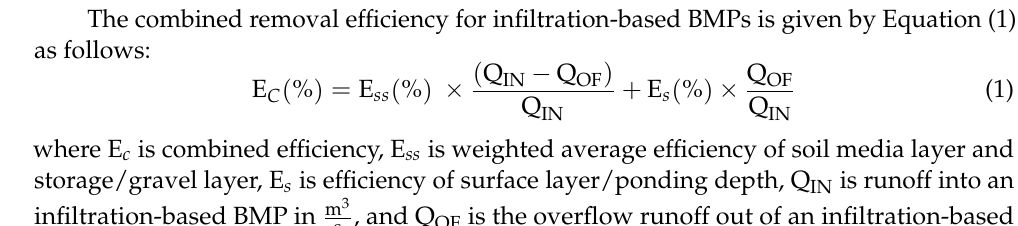
Figure 2. Conceptual diagram for pollutant removal processes in infiltration-based BMPs.